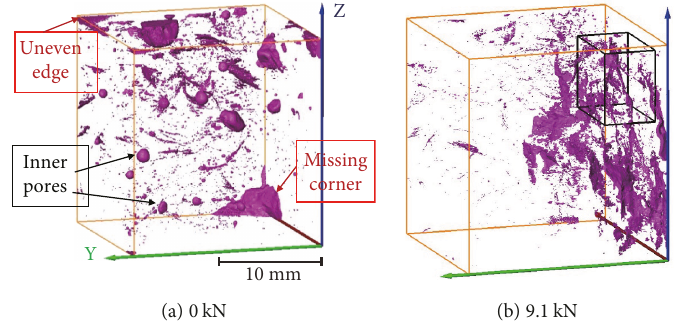
Figure 3: Segmented cracks and voids under (a) 0 kN and initiated cracks at (b) 9.1kN.